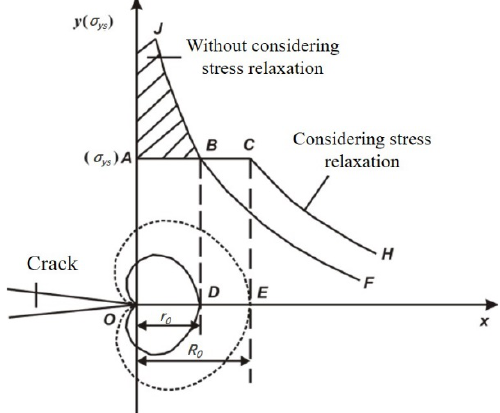
Figure 3. The effect of stress relaxation on fracture process zone size [25].